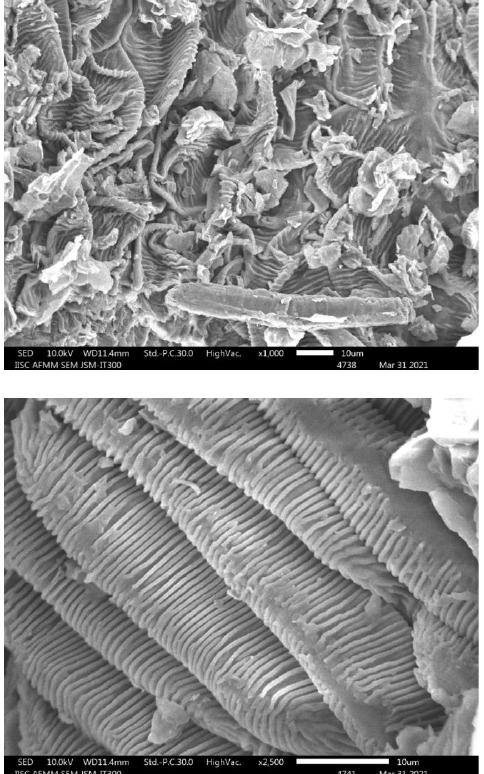
Figure 3. SEM images of WCP observed at 1000x (top) and 2500x (bottom) magnification